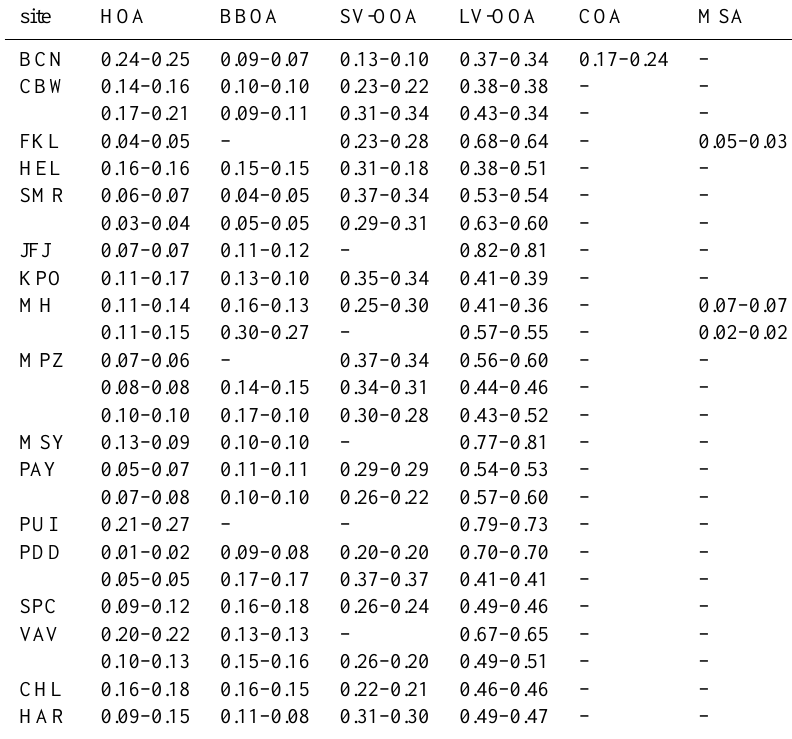
Table 3. Sensitivity analysis for the HOA factor ( a value range = 0-0.2, a value for BBOA = 0.3 if constrained). The relative contribution of OA sources to the total OA is reported varying the HOA a value.